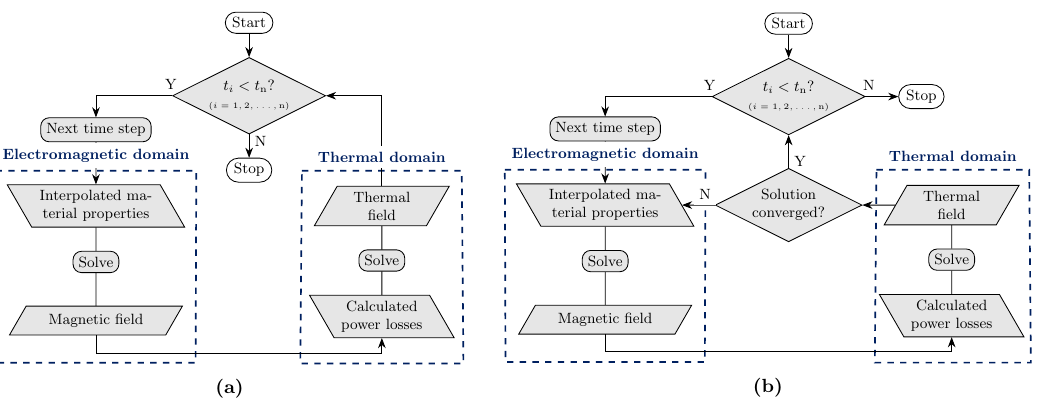
Figure 2. Comparison of coupling approaches: ( a ) one-way coupling; ( b ) two-way coupling.